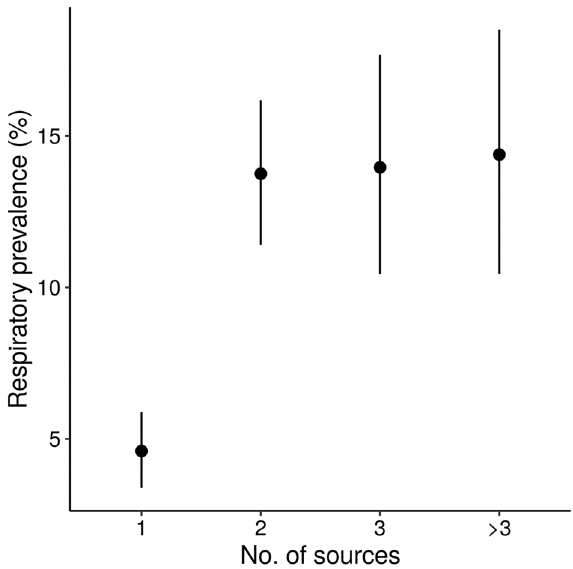
Figure 3. The effect of the number of source farms from which pigs are acquired on the respiratory prevalence at slaughter. Respiratory prevalence was calculated from the counts of respiratory conditions and the total pigs in the batch. Circles denote the mean posterior estimates and vertical line segments show their 95% highest density